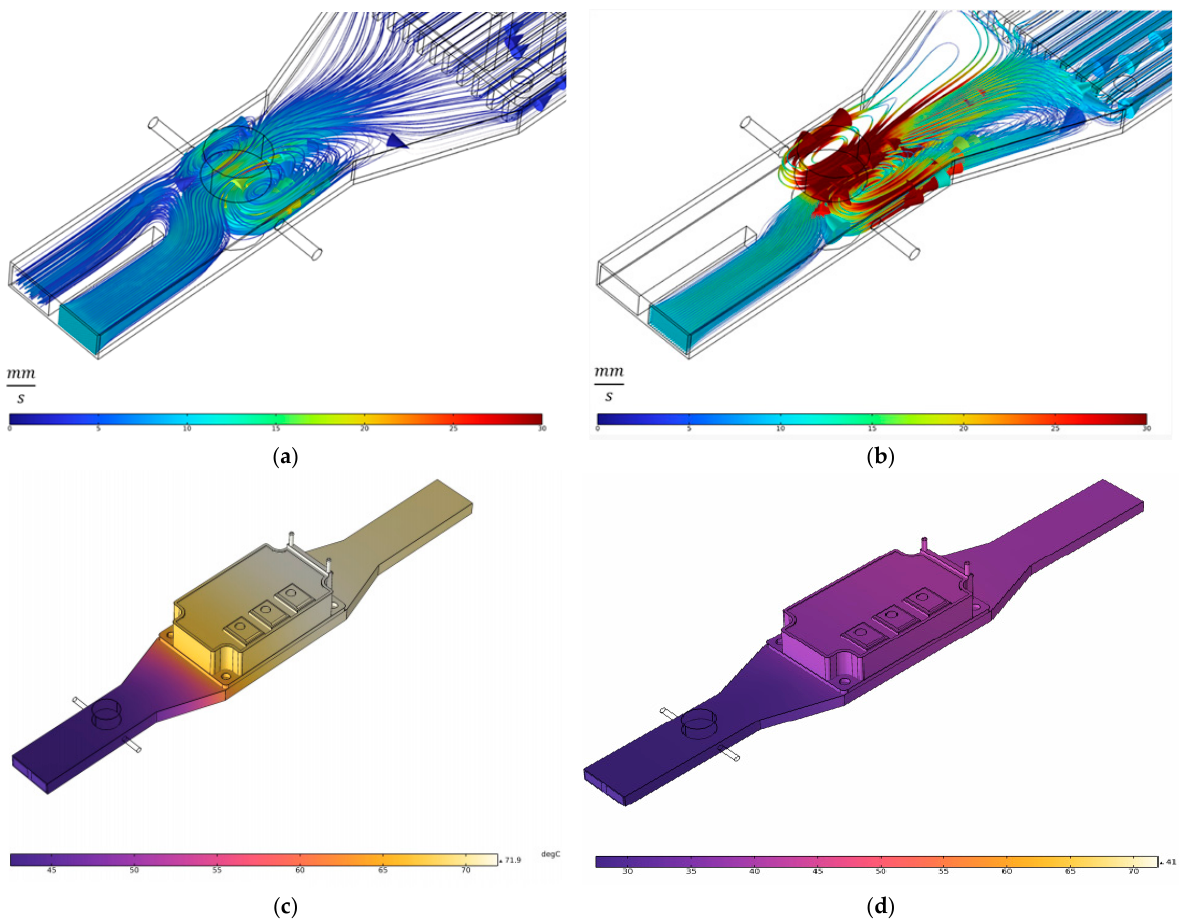
Figure 7. ( a ) Flow streamlines in cooling channel with backflow, ( b ) Flow streamlines in cooling channel without backflow, ( c ) Inverter temperature with backflow and ( d ) Inverter temperature without backflow.